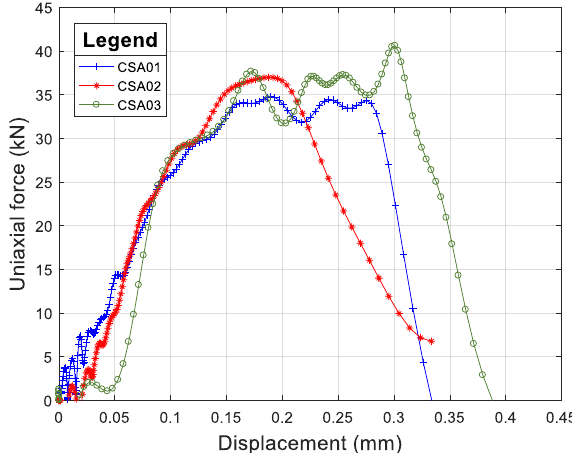
Figure 11. Uniaxial force vs differential displacement response for tests CSA01, CSA02, and CSA03. The equivalent plastic strain versus time and equivalent stress versus time calculated from Equations (1) are plotted in the Figure 12a and Figure 12b, respectively. The main difference between the CSA03 sample and the CSA01 and CSA02 samples was that no pulse-shaper was used with the CSA03 test. This explains the larger oscillations associated with the CSA03 test data.